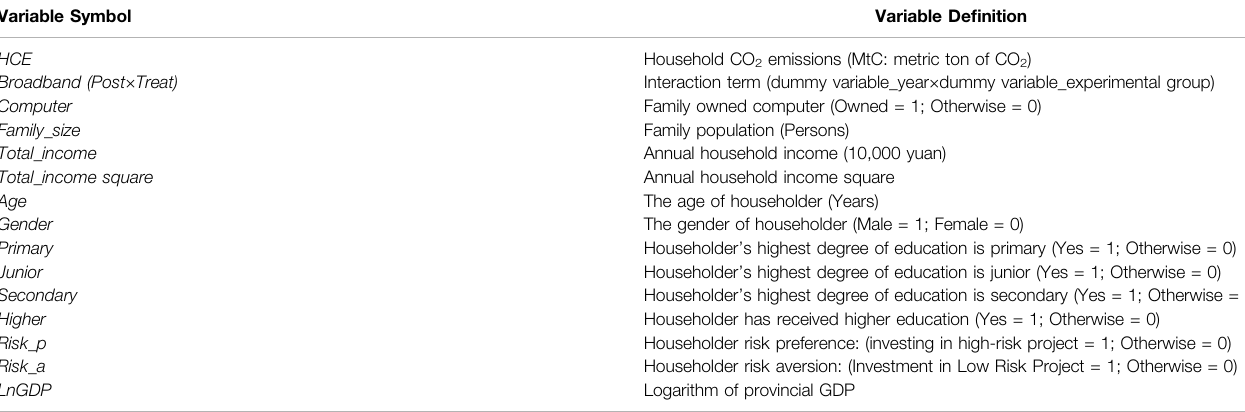
TABLE 1 | Variables de fi nition.